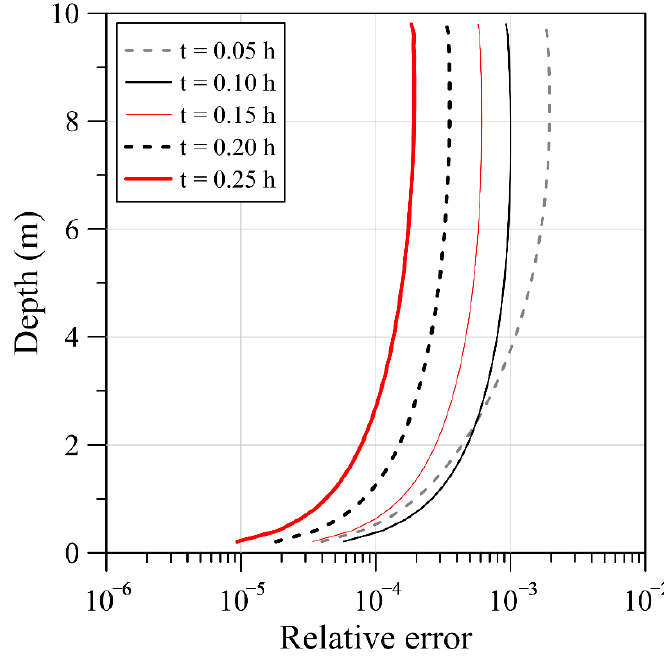
Figure 11. Relative error of the computed results using the RBF.